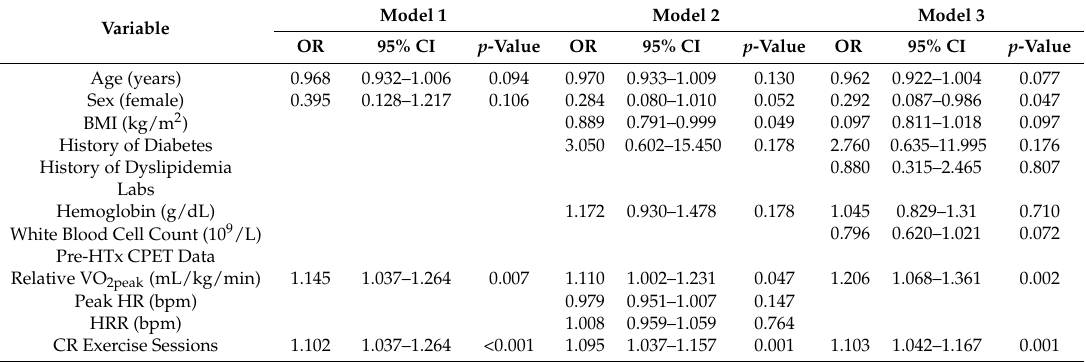
Table 4. Adjusted and multivariate regression analysis for predictors of Post-HTx VO 2peak .